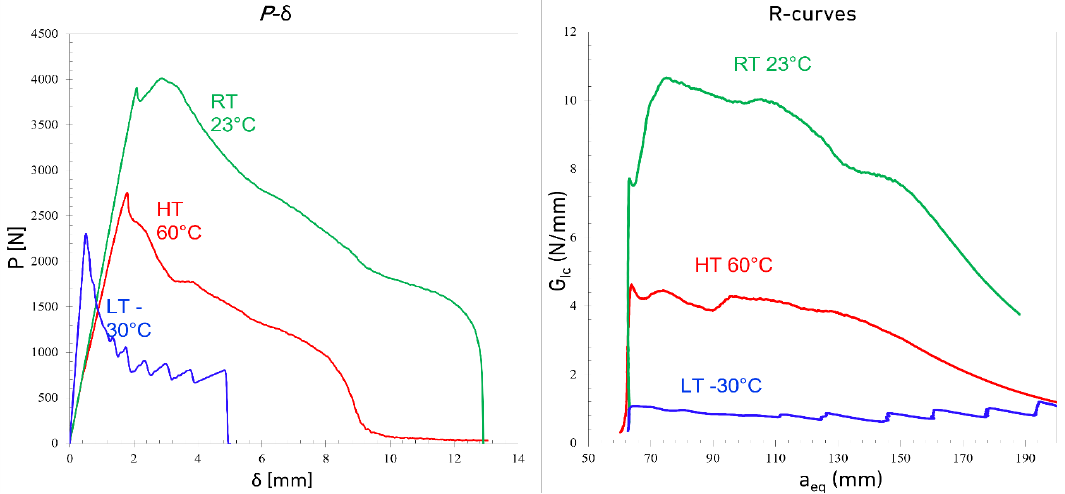
Figure 5 . Representative Load-displacement curves of DCB joints under high loading rates (6000 mm/min) at different temperatures .